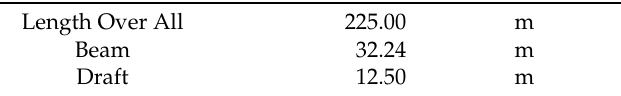
Table 1. Main dimensions of the Panamax bulk carrier.